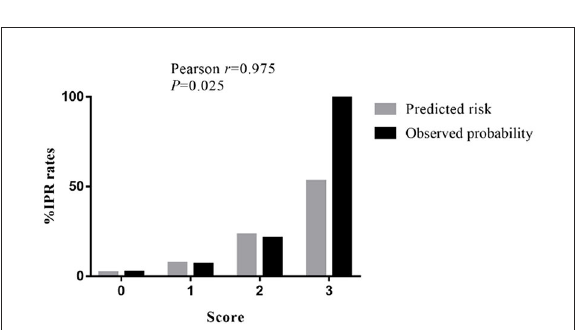
FIGURE3 Rates of IPR by the clinical score for patients with SRAs. The predicted rates of patients with SRAs with a score of 0, 1, 2, and 3 have IPR rates of 2.1, 7.4, 23.0, and 53.0%, respectively. The observed rates of patients with SRAs with a score of 0, 1, 2, and 3 have IPR rates of 2.4, 6.7, 21.1, and 100%, respectively. IPR, intraprocedural rupture; SRAs, small ruptured